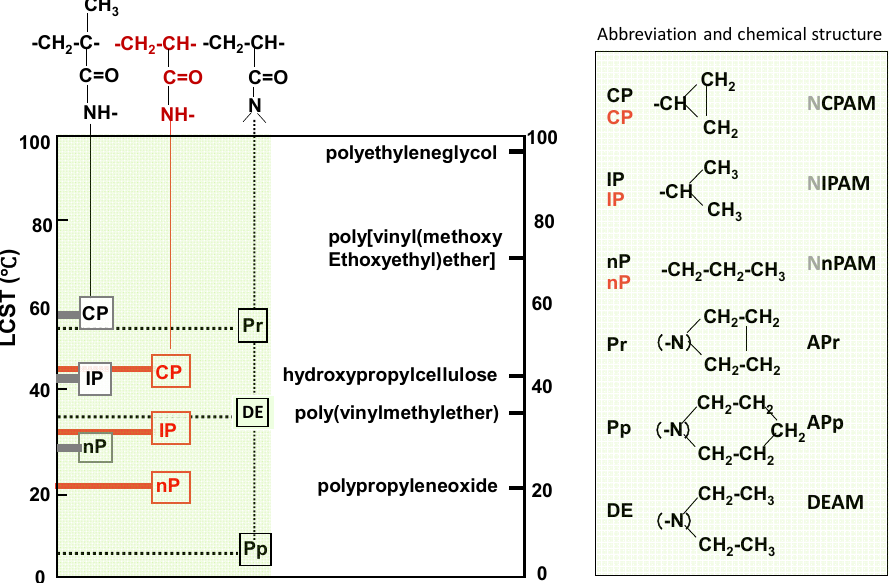
Figure 5. Volume phase transition temperaturs of acrylamide -derivative polymers and some other polymers.